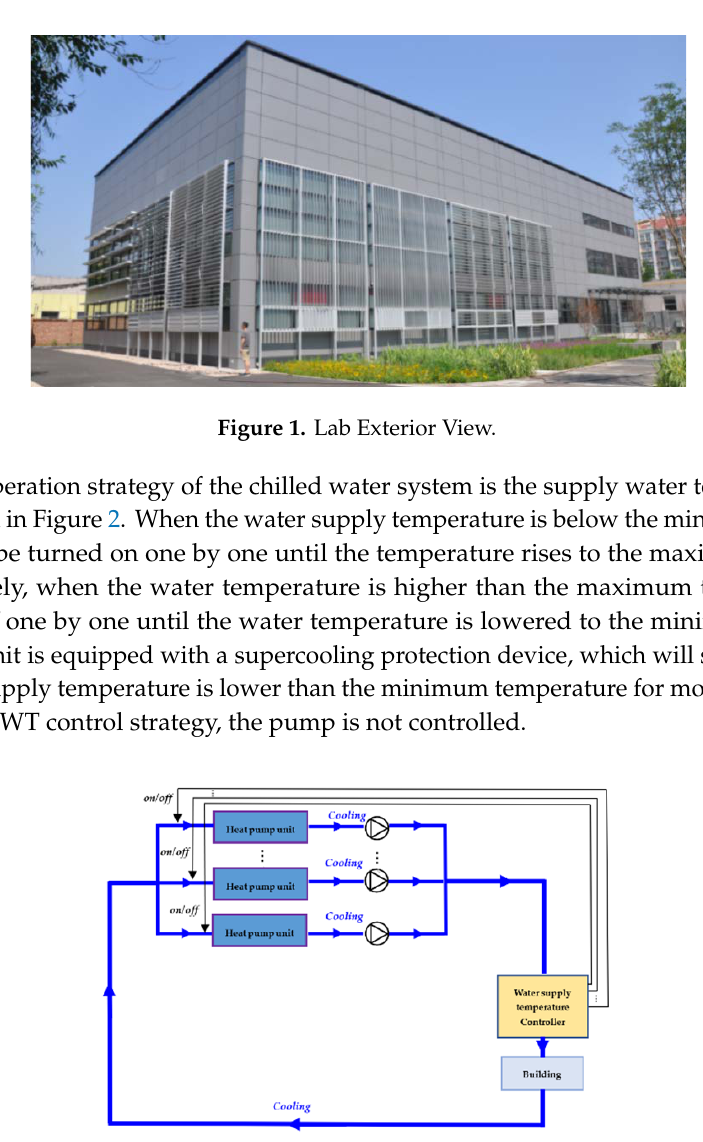
Figure 2. The logic diagram of the supply water temperature (SWT) control strategy.